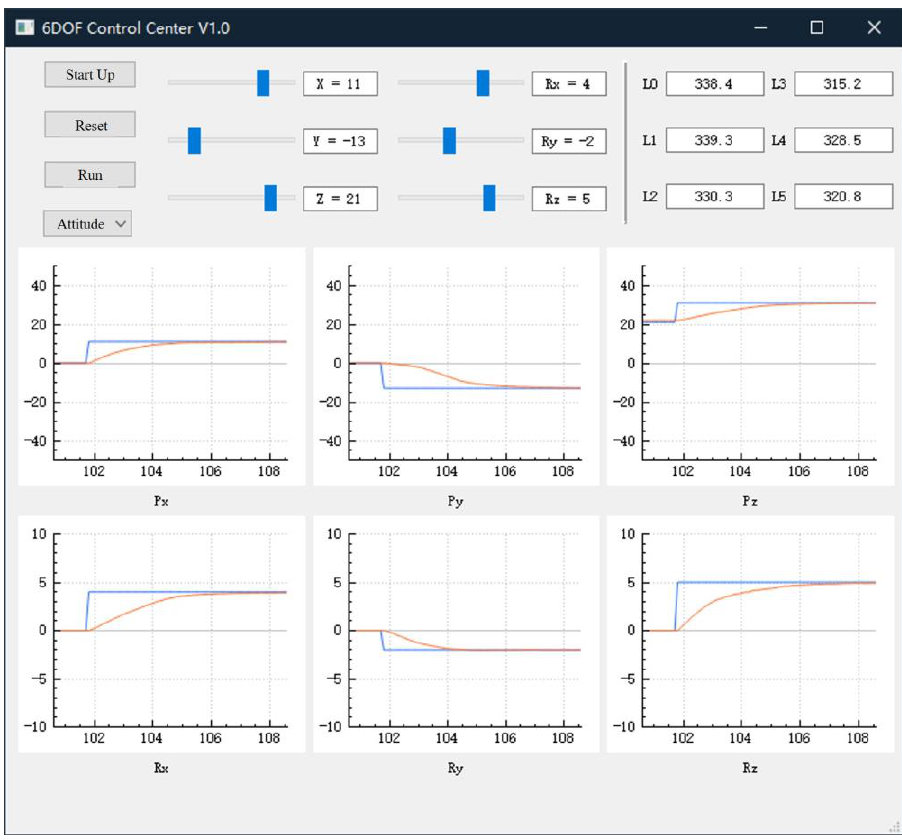
Figure 25. Attitude closed-loop control image.